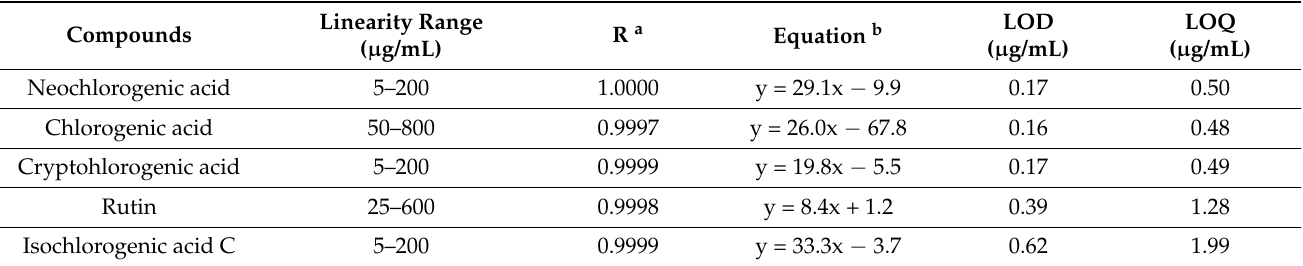
Table 1. Regression equation, linearity, LODs and LOQs of the investigated components.